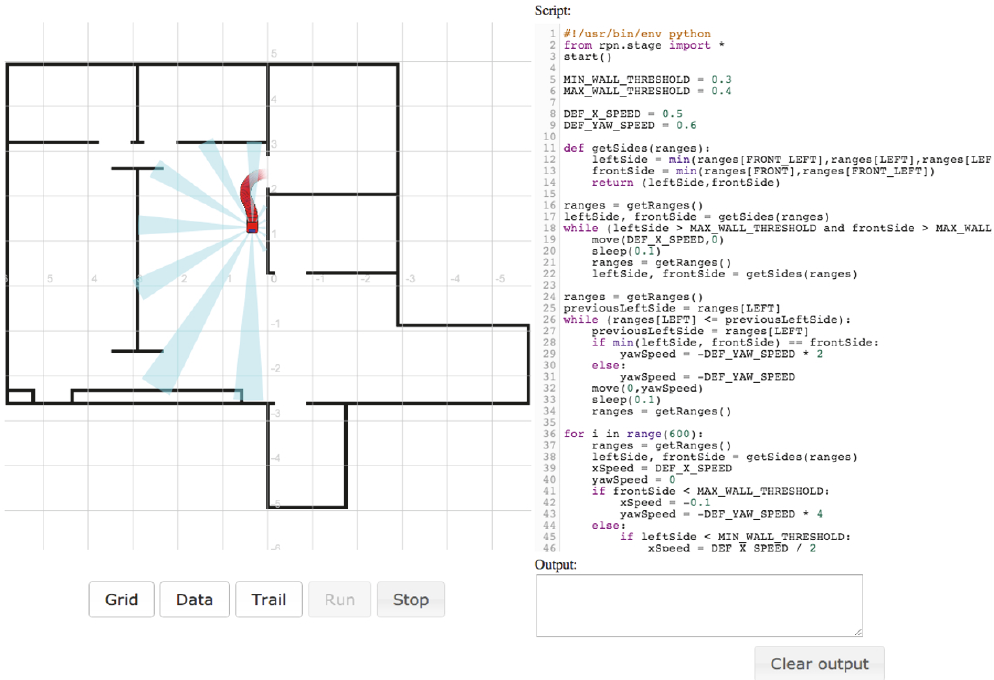
Figure 5: Programming environment of the course “Introduction to Mobile Robots,” control buttons and simulation.